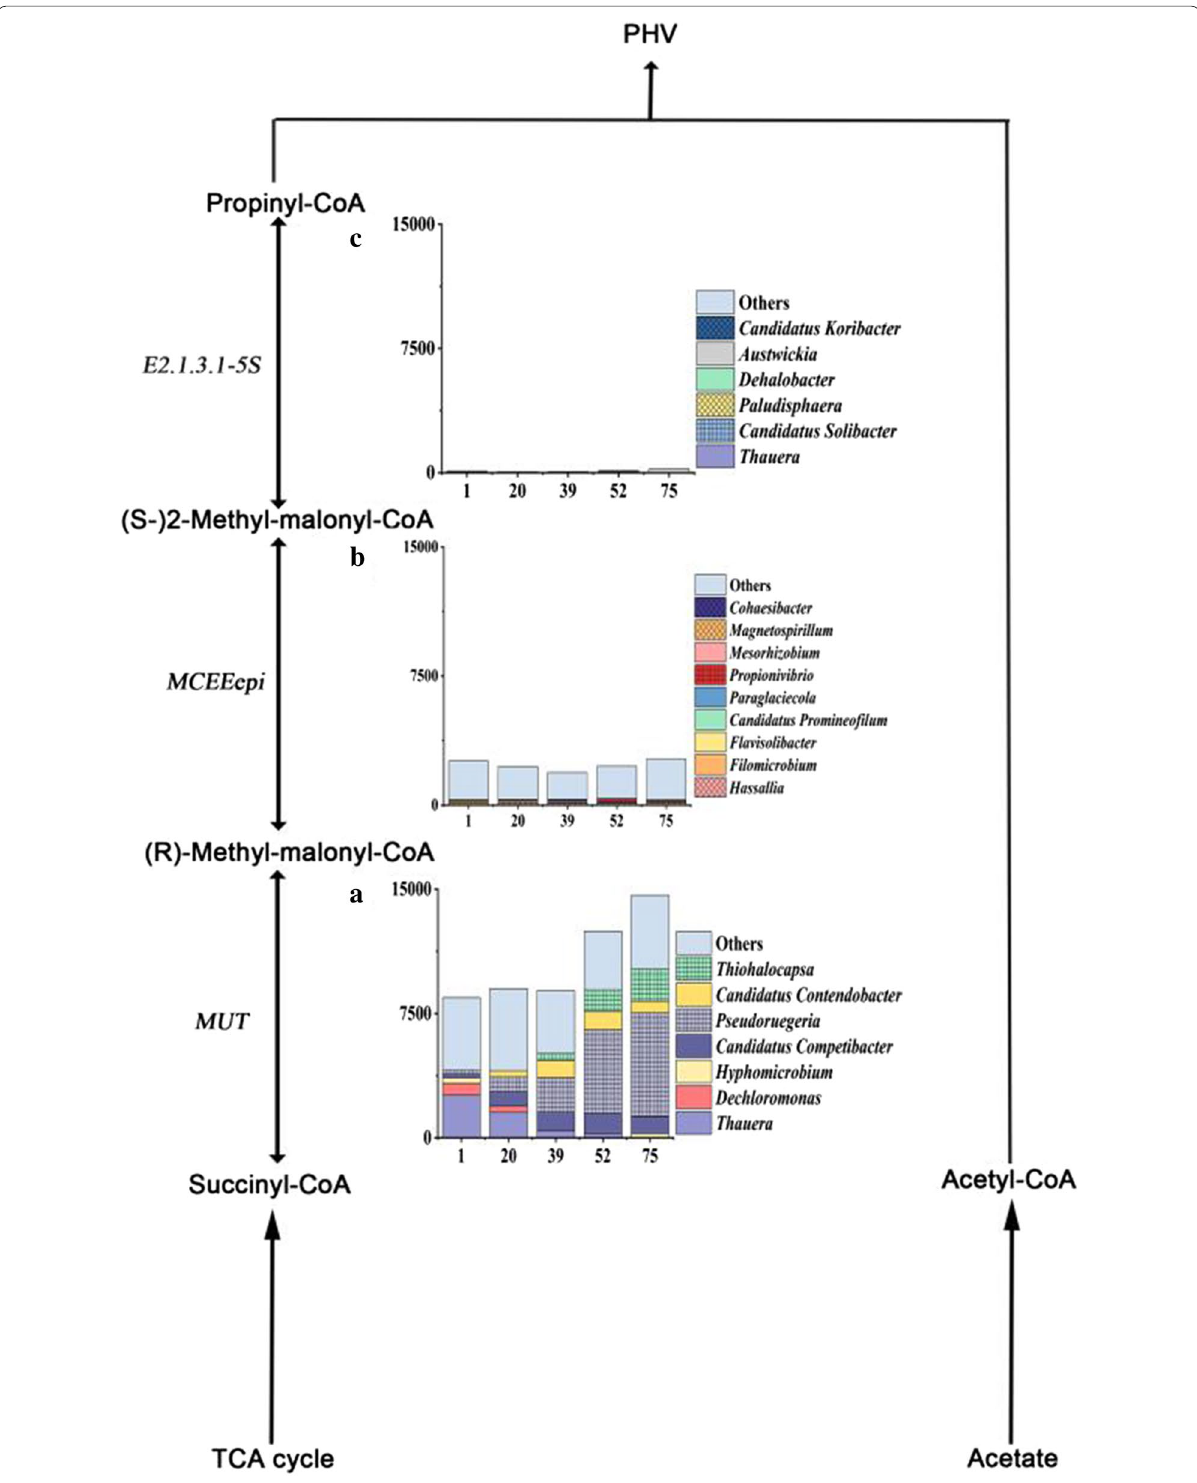
Fig. 4 The changes of the abundance of the first five genera containing key genes that regulate propionyl-CoA production via the succinate-propionate pathway. a–c Represent the abundance changes of the first five genera for MUT, MCEEepi, and E2.1.3.1-5S,